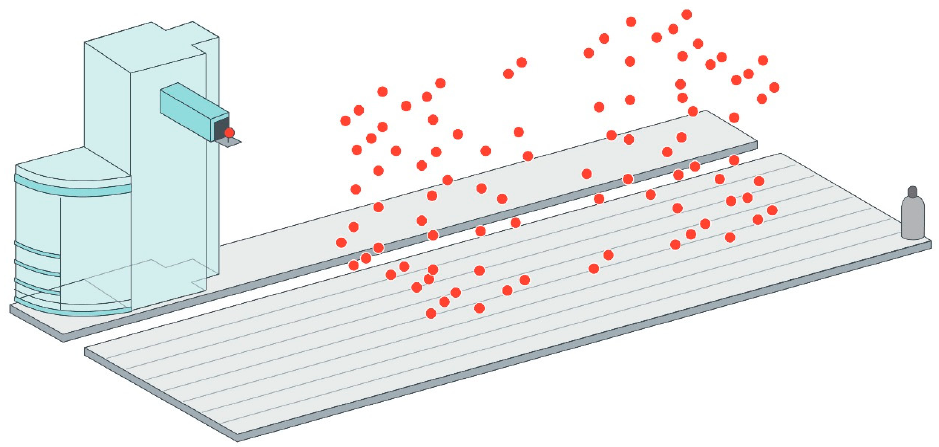
Figure 10. Tracking interferometer and multilateration combination approach.